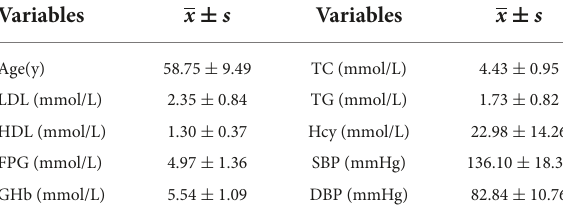
TABLE 1 Clinical parameters of study subjects (quantitative